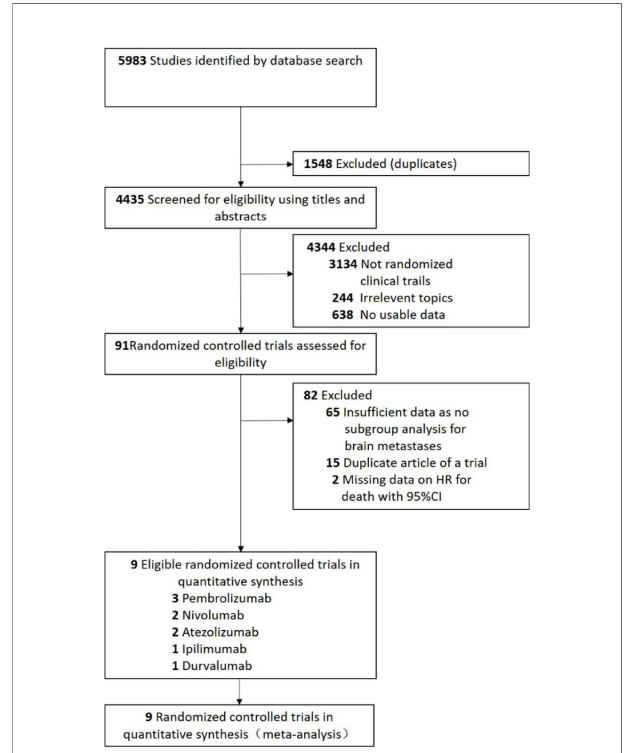
FIGURE 1 | Flow Chart Diagram of Study